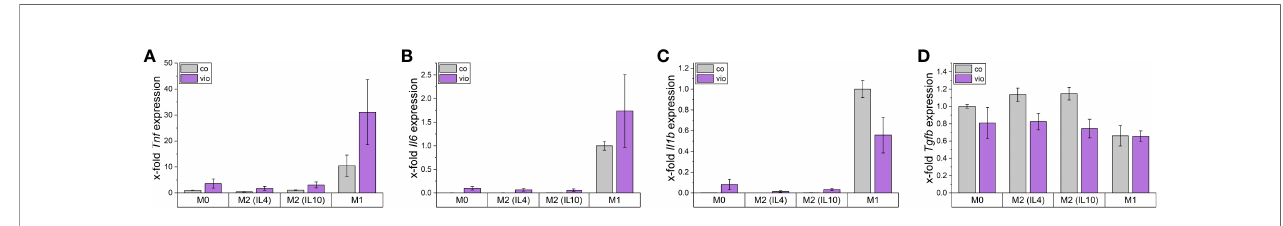
FIGURE 6 | Macrophage gene expression after violacein treatment. BMMs were incubated with respective polarization stimuli alone or with 5 µM violacein for 24 h. Gene expression was determined via qPCR and values were normalized to RnA18S as a housekeeping gene and untreated (A, D) M0 or (B, C)